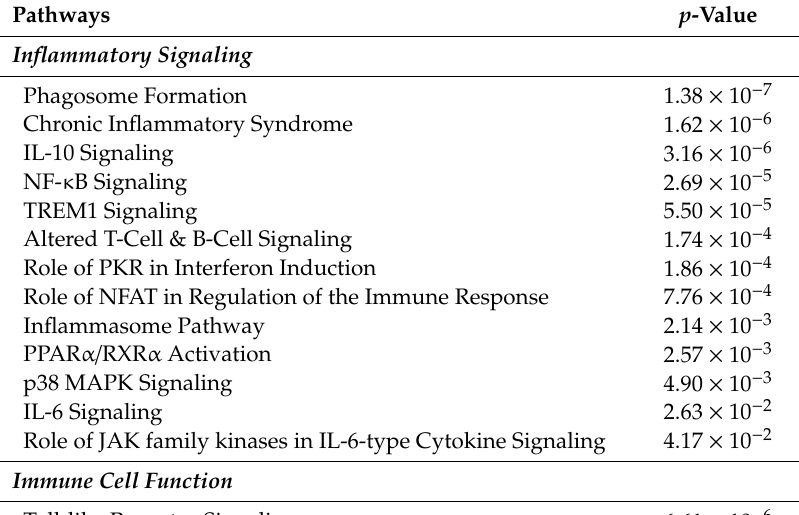
Table 3. Functionally relevant BMI-associated biological pathways ( n =